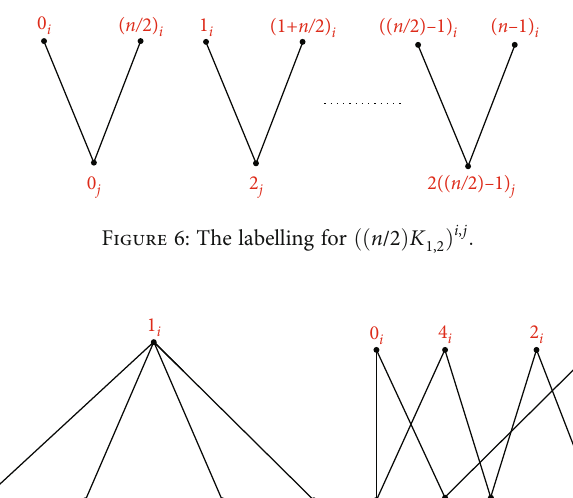
Figure 7: The labelling for ð C